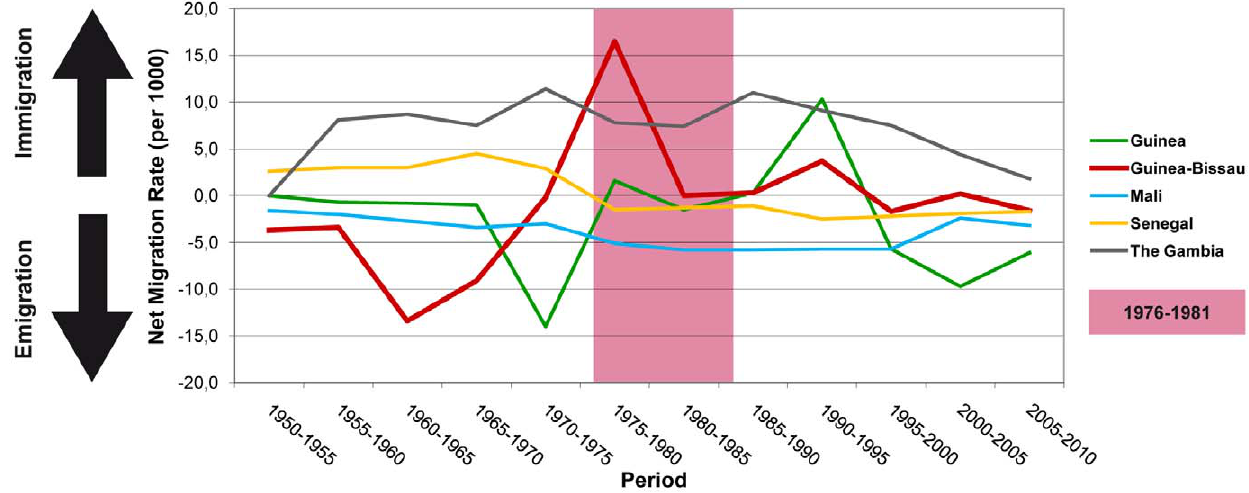
Figure 3. Net migration rates over 5-year intervals. Mean number of immigrating and emigrating people per 1000 individuals over different 5- year intervals from 1950 to 2010 for Guinea-Bissau and neighbouring countries (Guinea, Mali, Senegal, and The Gambia). The pink area highlights the time period of the estimated HIV-1 introductions into Guinea-Bissau. Data were obtained from the United Nations World Population Prospects (United Nations Population Division, 2010)